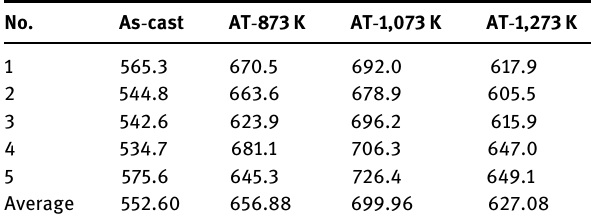
Table 3: Hardness HV 0.2 of the FeCoCrNiMo alloy at di ff erent annealing temperatures and as -